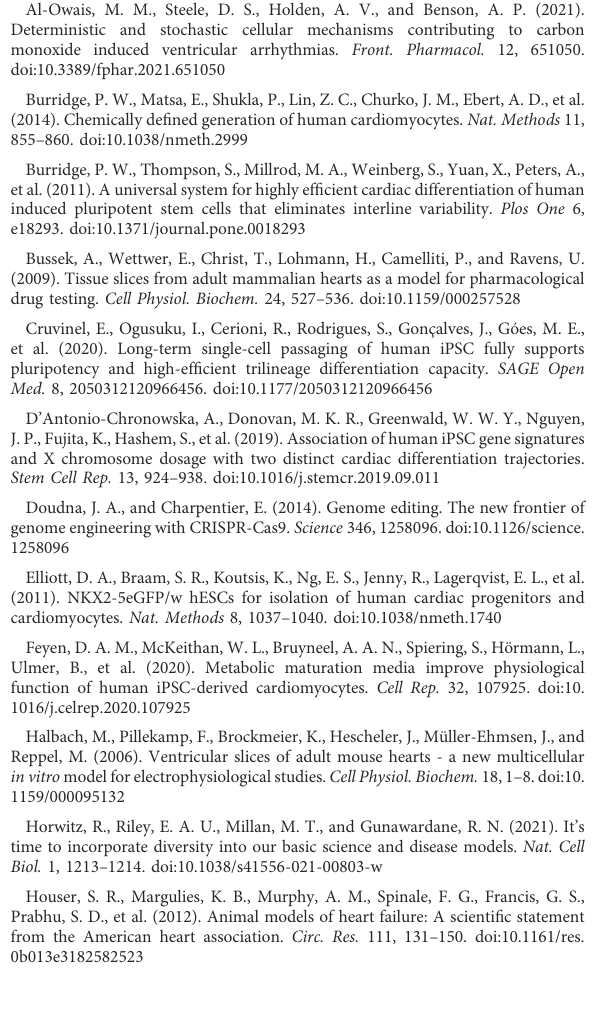
Correlation of action potential variables. The upper row shows scatter plots of action potential amplitudes (APA) as a function of maximum diastolic potentials (MDP) for different cell types (A) , differentiation protocols (B) and cell lines (C) . The center row shows scatter plots of maximum dV/dt (dV/dt max) as a function of MDP for different cell types (D) , differentiation protocols (E) and